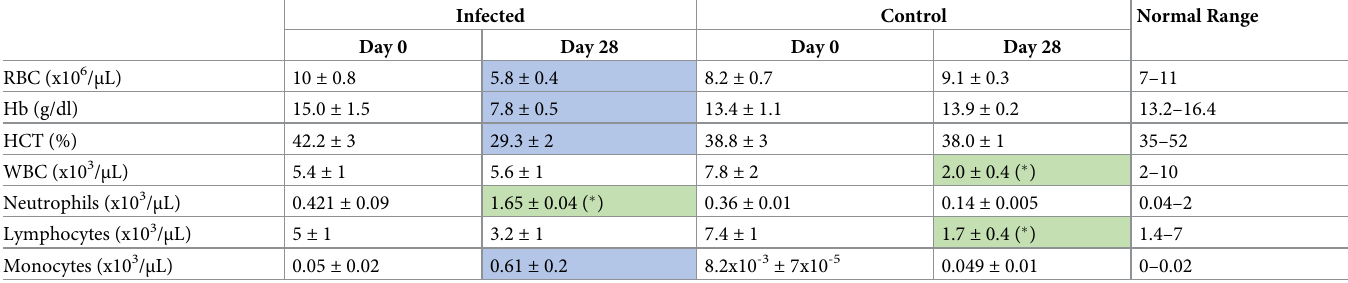
Table 1. Cell counts for the infected and control spleens. Haematological results. The cell counts from the blood samples taken from the infected and control experi- mental groups at day 0 (before infection) and day 28 post infection. There was a significant difference in all cell counts apart from lymphocytes and white blood cells between day 0 and day 28 in the infection group. In the control group between day 0 and 28 there was a significant difference (p < 0.05) for the white blood cells and the lymphocytes, but these values were still in the normal literature range. Significance is denoted with the blue box. Significance where the values are still in normal range are denoted by the green box and ( �